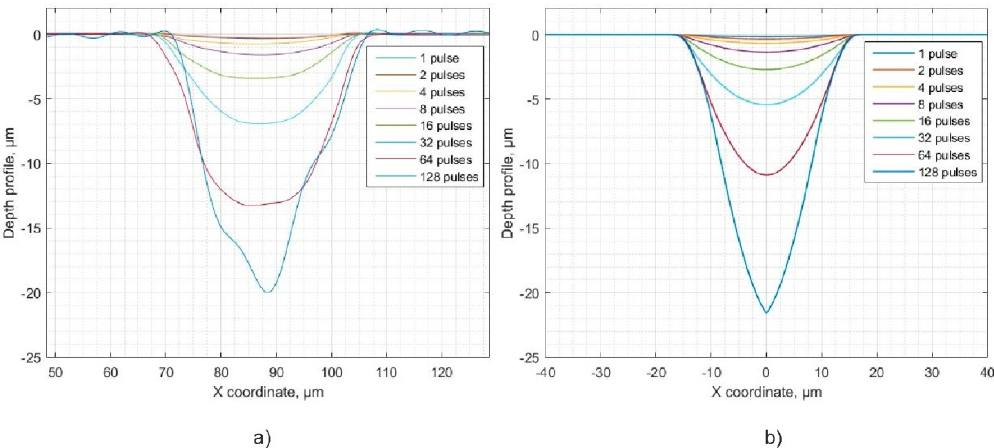
Figure 3. Experimentally acquired ablation crater profiles ( a ) and numerically simulated crater profiles using Equation 4 ( b ). The pulse energy is 160 µJ (fluence = 29 J/cm 2 ) in this case.